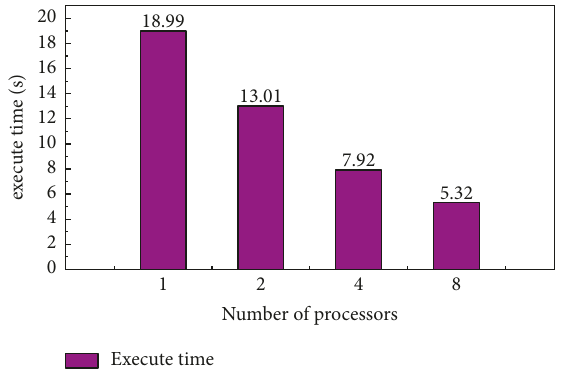
Figure 4: Comparison of execution time of processors with dif- ferent